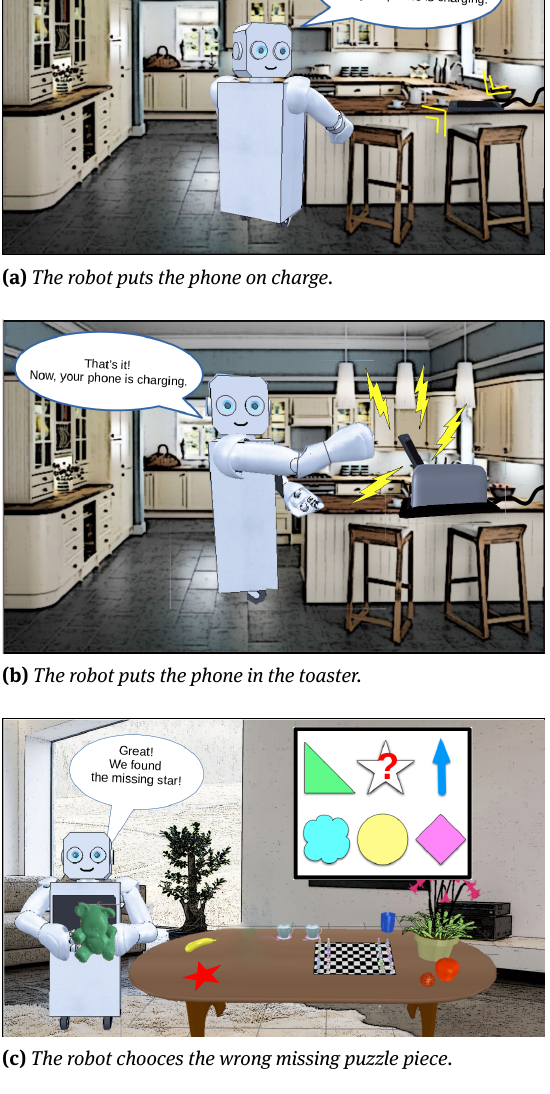
Figure 3: Example of correct and erroneous robot’s behaviours. In Figure a) and b) the participant asks the robot to charge her